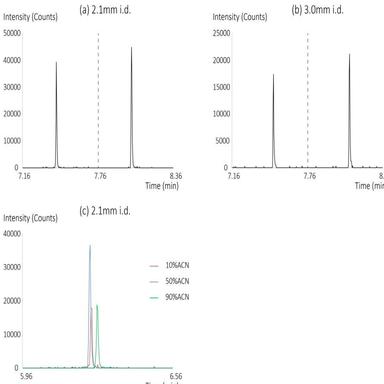
Illustration of injection solvent effects in 2D-SFC under on-line LC x SFC conditions. Two successive separations of caffeine in SFC with two column internal diameters: (a) 2.1 mm and (b) 3.0 mm. (c) Effect of the injection solvent on a 2.1 mm i.d. column, 1D conditions: no column, solution of caffeine (50 ppm in acetonitrile/water 50/50) at 10 μL/min, 30 °C, sampling time: 0.6 min. 2D conditions: Acquity BEH HILIC (50 × 2.1 mm; 1.7 μm), PBPR: 150 bar, A: CO2, B: ACN/MeOH (50/50), 5% to 30%B in 0.25 min, 1.